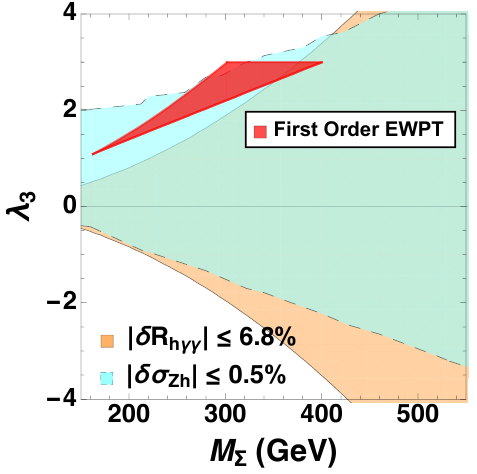
Figure 9. Contours same as that in figure 8 with superposition of the red region denoting the first order phase transition presented in ref.